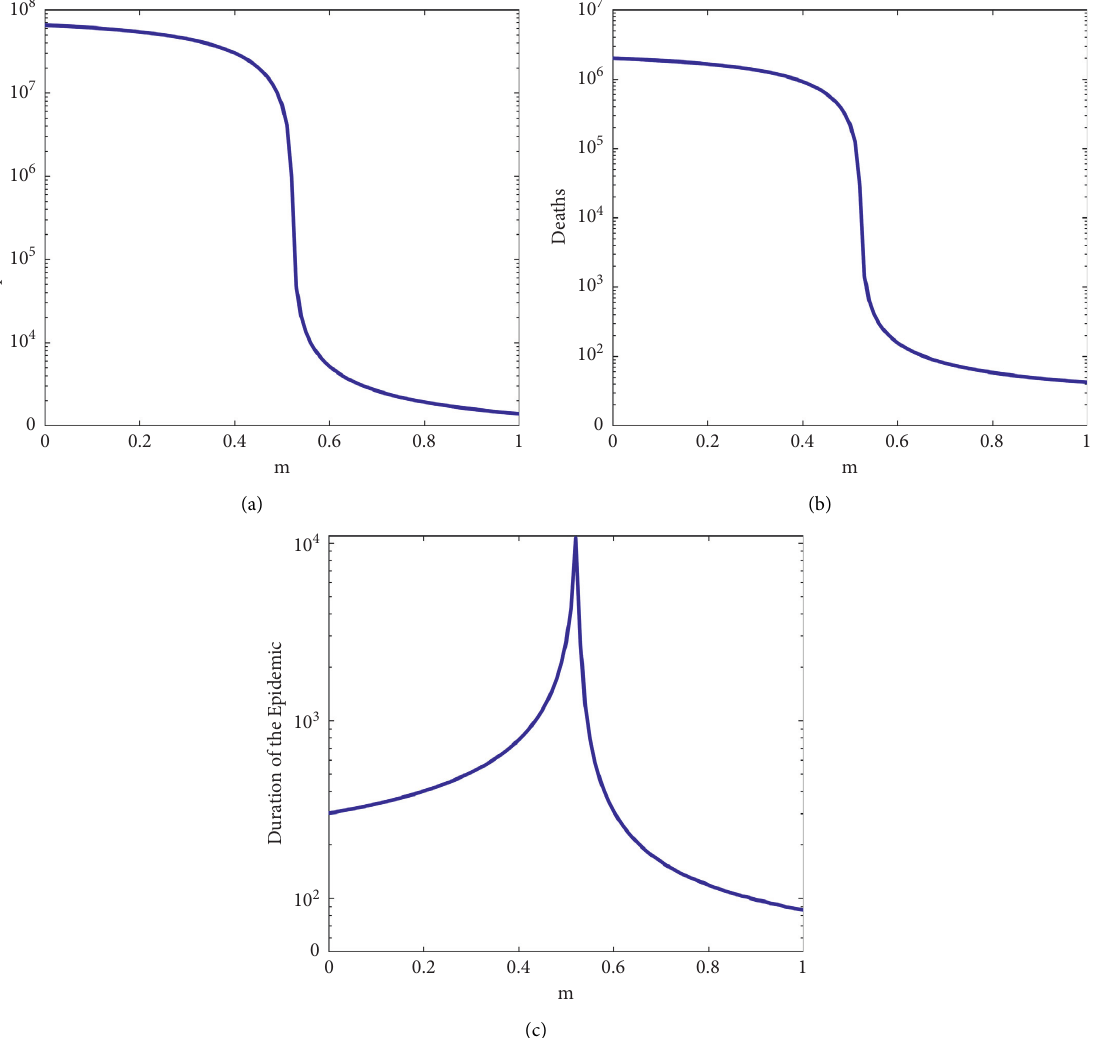
Figure 3: Diagnosis rate ] � 0 . 2 and start time of taking measures t deaths, and (c) the duration of the epidemic with the change of measures